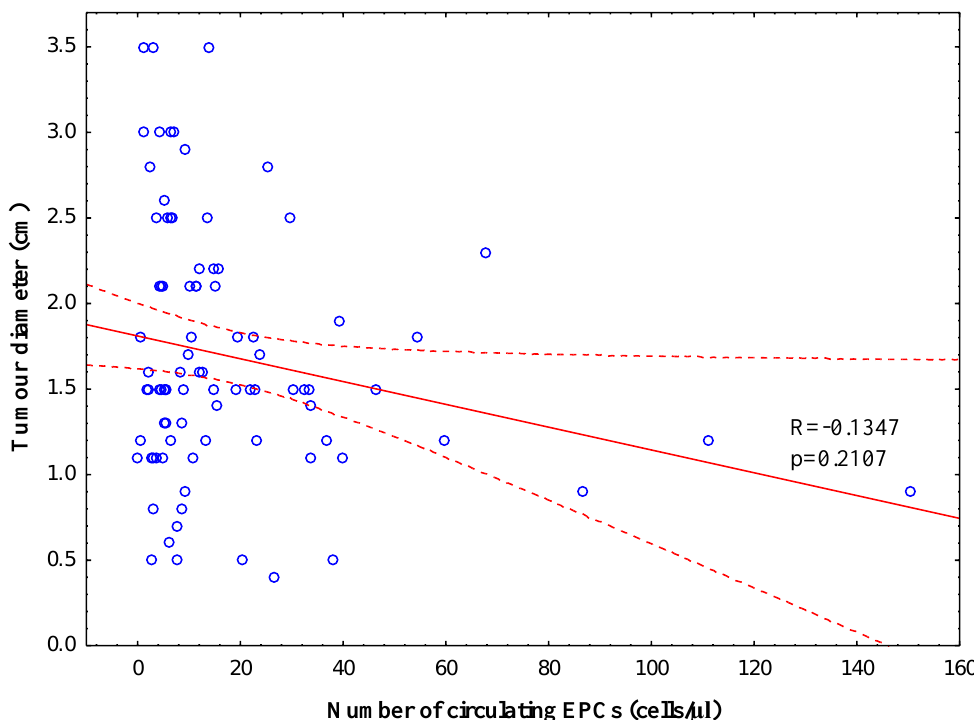
Figure 6. Scatter plot shows a lack of correlation between a pre-treatment number circulating endothelial progenitor cells (EPCs) with tumour diameter (Spearman correlation coefficient, R = −0.1347; p = 0.2107).